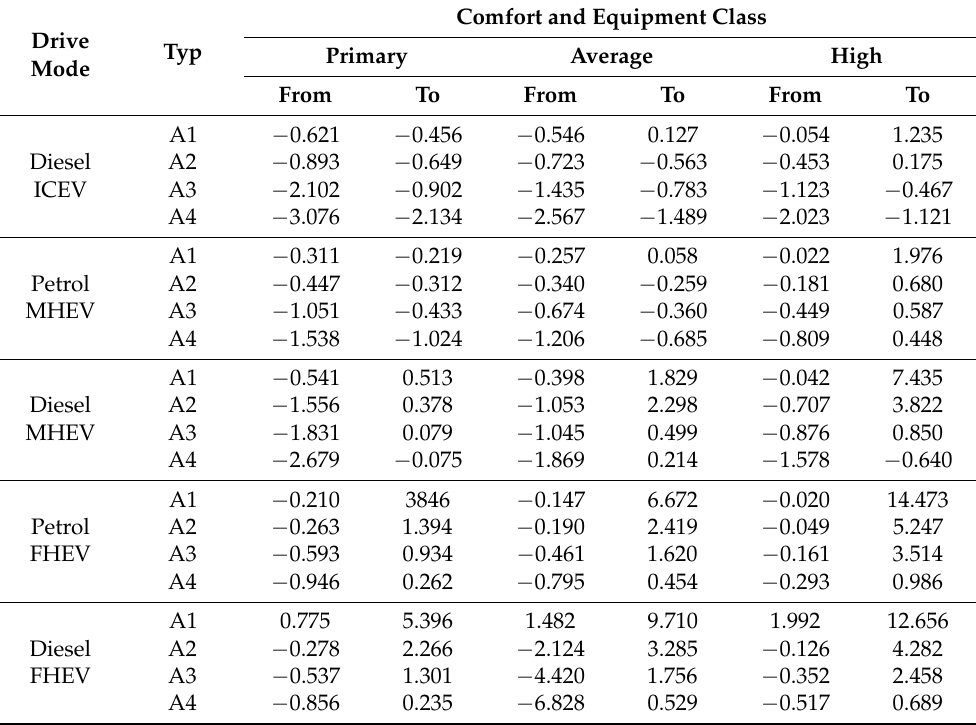
Table 7. Total cost of DTCO use for various drives of SUVs depending on the equipment class and taking into account the model including aperiodic and other phenomena that may affect the TCO for a given group for